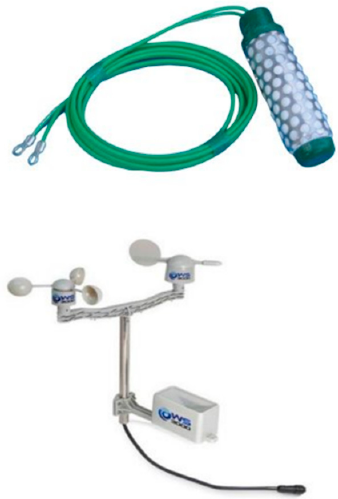
Figure 5. Watermark Soil Moisture Sensor and Weather Station having Rainfall Sensor.